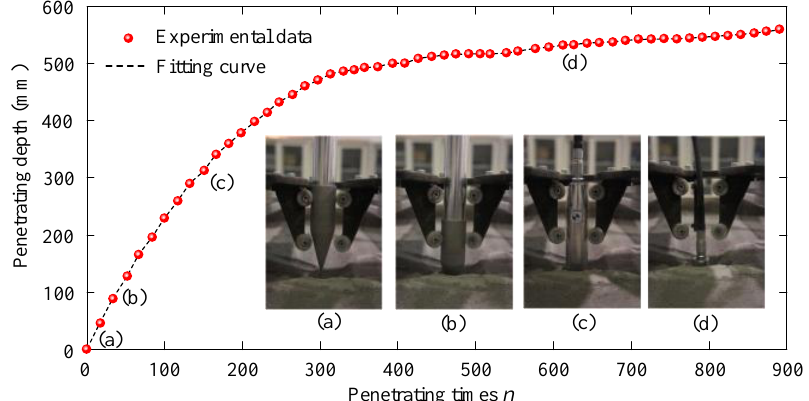
Figure 14. The penetrating depths into the lunar soil simulant under different impact